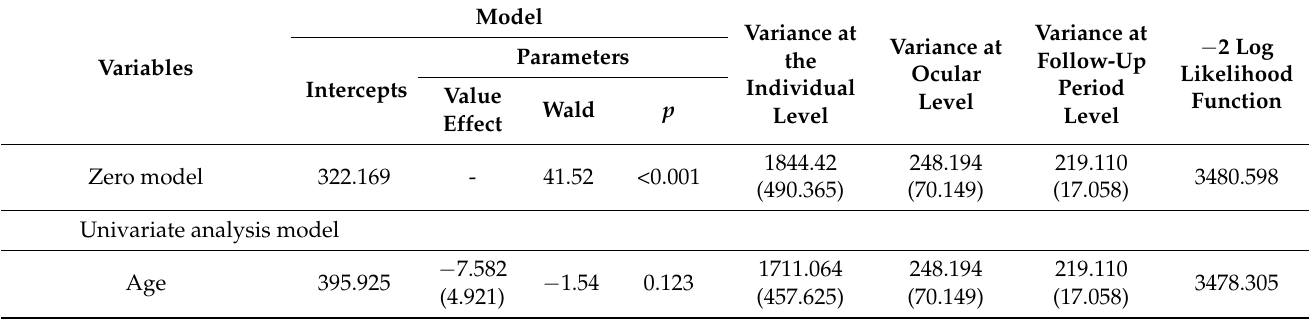
Table 4. Personalized predictive modeling of subfoveal choroidal thickness for myopia adolescents after